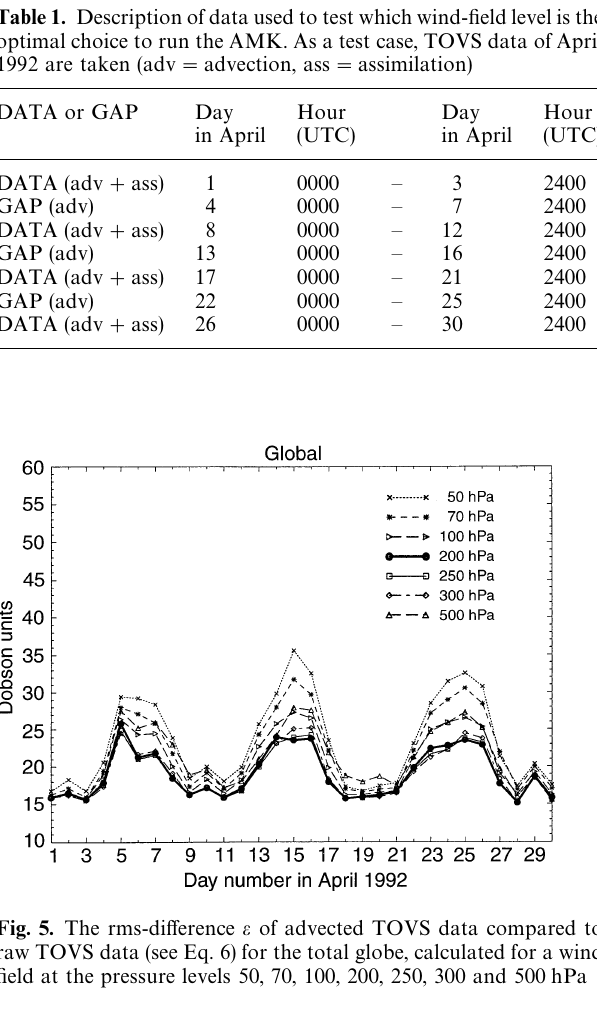
Fig. 8. As in Fig. 5 but only for the EQ region (30 ° N — 30 °